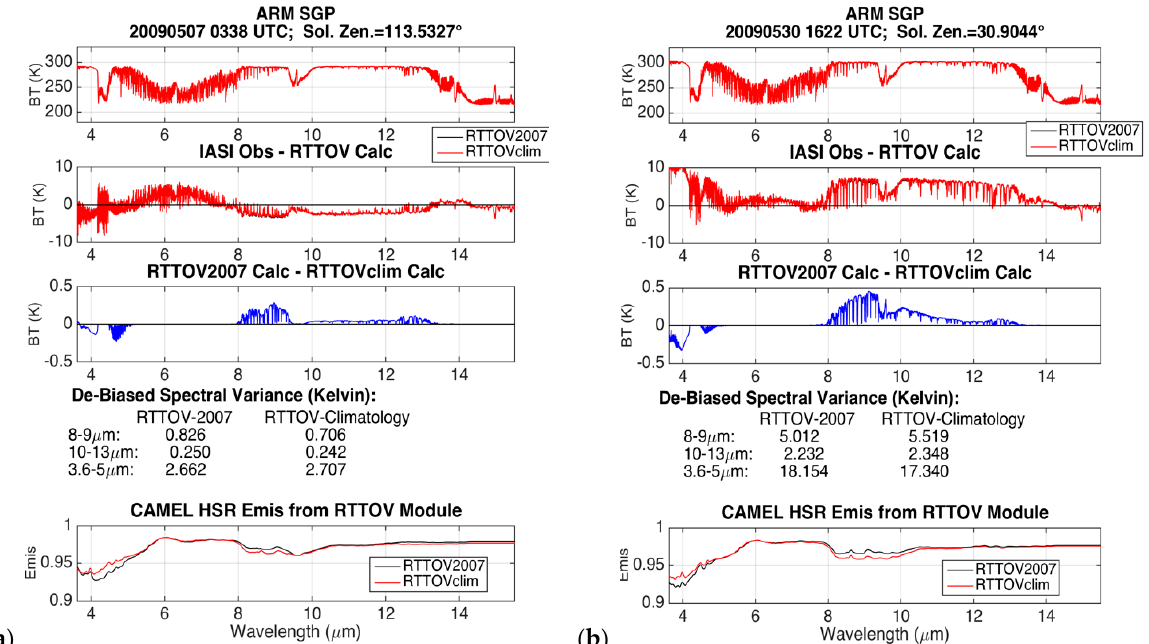
Figure 11. Comparison of IASI BTs calculated using the current RTTOV emissivity module (“RTTOV2007”) and the updated module (“RTTOVclim”) for the ARM SGP site on ( a ) May 7th, 2009 at 03:38 UTC and ( b ) on May 30th, 2009 at 16:22 UTC. Top panel shows the RTTOV calculated BTs overlaid for each emissivity module, second from top panel shows IASI observed minus calculated BT again overlaid for each emissivity module (RTTOVclim curve in red is overlaying the RTTOV2007 curve in black), third panel from top shows calculation differences, bottom panel shows the RTTOV CAMEL emissivities overlaid. The de-biased spectral variances are listed in Kelvin 2 for each observation minus calculation difference for three spectral regions. Solar zenith angle is noted in the top title. Table 3. RTTOV calculated minus IASI observed 10–13 µ m day+night de-biased BT variances (listed in units of Kelvin 2 )